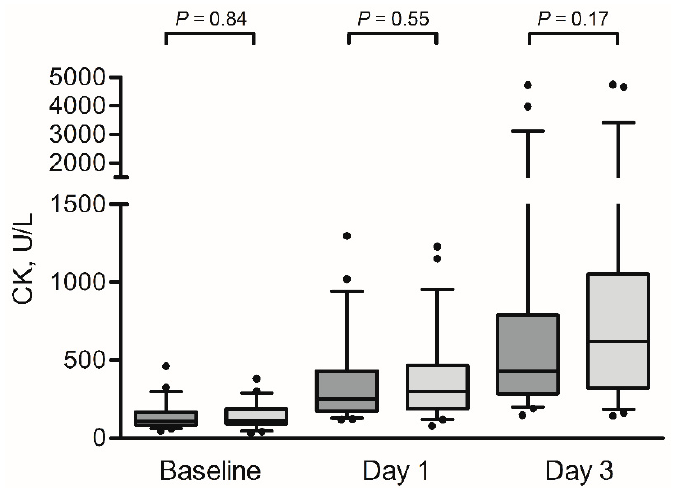
Figure 3. Box-and-whisker plots for creatine kinase (CK) at baseline, after day 1 and after day 3. The box-and-whisker plots represent the median, interquartile range, 5–95% percentile (upper and lower whiskers) and outliers (dots) of creatine kinase (CK) for the protein group (dark grey) and the placebo group (light grey). Prolonged walking resulted in elevated CK levels in both groups ( p < 0.001). No significant differences were observed between the groups at the different time points (all p > 0.05).